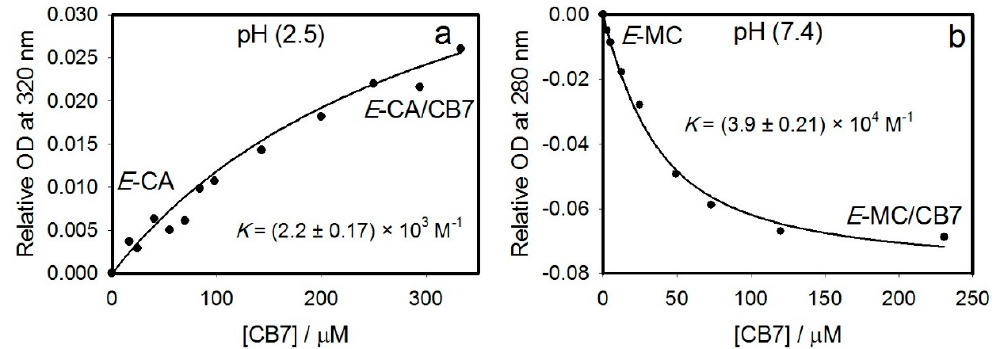
Figure 2. Binding affinities of E -CA (a) and E -MC (b) substrates (18 μ M) with CB7 (the structures are given in Scheme 1) determined by titration based on UV–visible absorption spectra. The insets show the nonlinear fitting to a 1:1 binding model solid line (Experimental Section). OD is the optical density. Relative OD is the difference between the absorbance in the absence and presence of CB7.